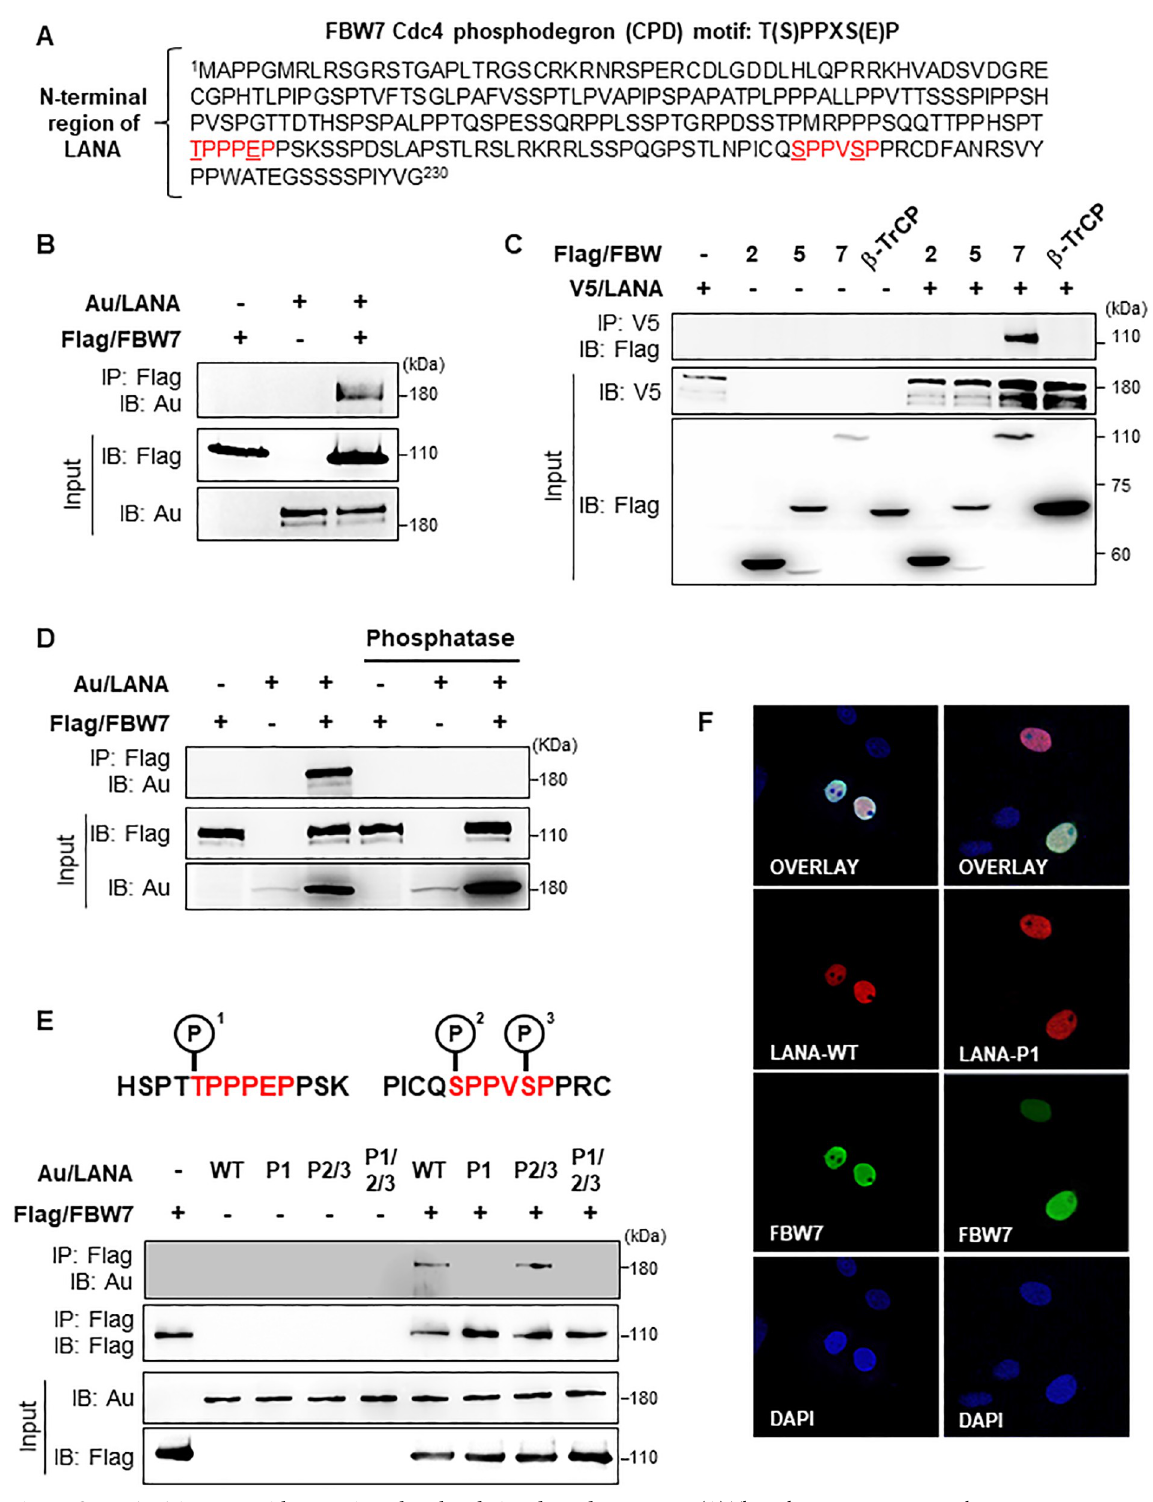
Fig 1. KSHV LANA interacts with FBW7 in a phosphorylation-dependent manner. (A) The red sequences represent the FBW7 consensus binding motif present in the N-terminal region of LANA. (B) 293T cells were transfected with the indicated constructs, followed by immunoprecipitation (IP) with an anti-Flag antibody and immunoblotting (IB) with an anti-Au antibody. (C) 293T cells were co-transfected with LANA and the indicated F-box/WD repeat constructs, followed by IP with an anti-V5 antibody and IB with an anti-Flag antibody. (D)